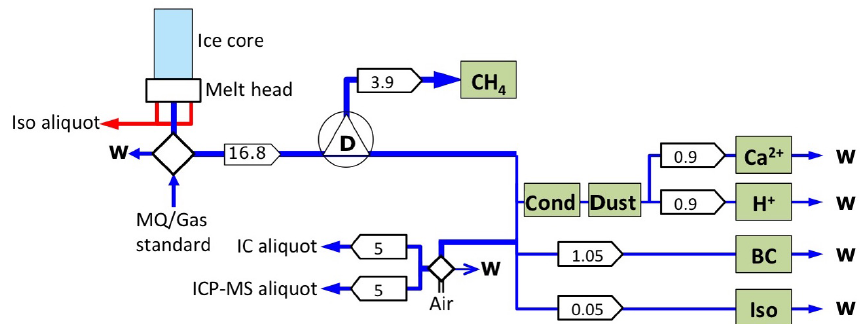
Figure 3. The RICE CFA setup. A 1m long ice-core rod (light blue) is placed on a melt head, which separates meltwater from the pristine inner part of the core from that of the more contaminated outer rim. Meltwater from the outer stream (red) is used for discrete measurements of water isotopes, while the meltwater stream from the inner core section (dark blue) passes through a debubbler (D), which separates air from the meltwater. The air composition is analyzed for methane concentration, while the meltwater stream is channeled to various analytical instruments for continuous impurity analysis of dust, conductivity (cond), calcium (Ca 2 + ), acidity (H + ), black carbon (BC), and water isotopes (Iso), as well as collected in vials for discrete aliquot sampling by IC and ICP-MS. W denotes wastewater. Diamonds represent injection valves used for introduction of air or water standards when the melter system is not in use. Arrow boxes indicate liquid flow rates in mLmin − 1 . Green boxes represent analytical